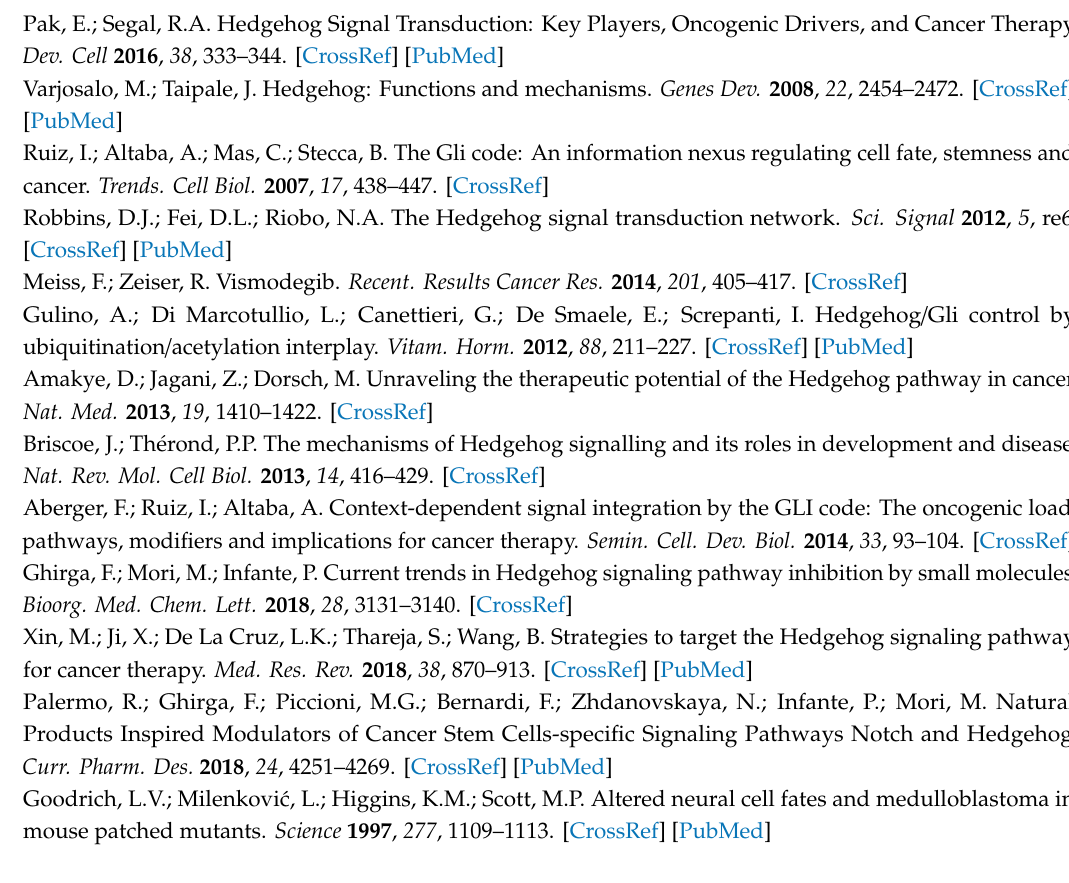
Figure S1: Hh inhibition by compound 20 . Dose-response curve in SAG-treated NIH3T3 Shh-Light II cells, Figure S2: General procedure for the synthesis of compounds 20 – 22 . Characterization of compounds 20 – 22 , Figure S3: E ff ect of compounds 21 and 22 on overexpressed Gli1 protein, Figure S4: E ff ect of ATO, GANT61 and Vismodegib on Gli1 mRNA levels in Smo − / − MEFs, Figure S5: Compound 22 does not a ff ect Jun and WNT pathways, Figure S6: Inhibition of Gli2-induced transcription in MEFs WT treated with increasing concentrations of compound 22 , Figure S7: E ff ect of compound 22 on ciliogenesis and Gli1 localization, Figure S8: E ff ect of compound 22 on non-Hedgehog-dependent MB cell lines, Table S1: E ff ect of compounds 21 and 22 on Gli1 mRNA levels in Smo − / −